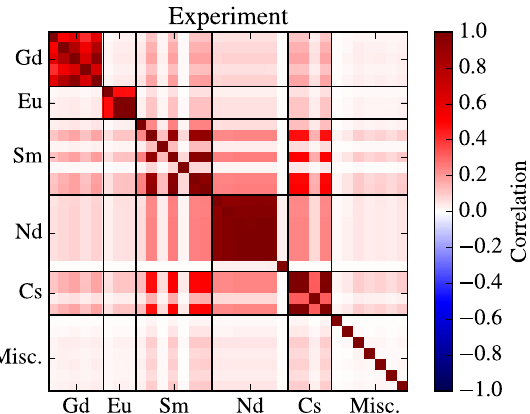
Fig. 2. Experimental correlations between the fission products in fuel sample U1. The miscellaneous FPs include Ag-109, Rh- 103, Ru-101, Tc-99, Mo-95, and